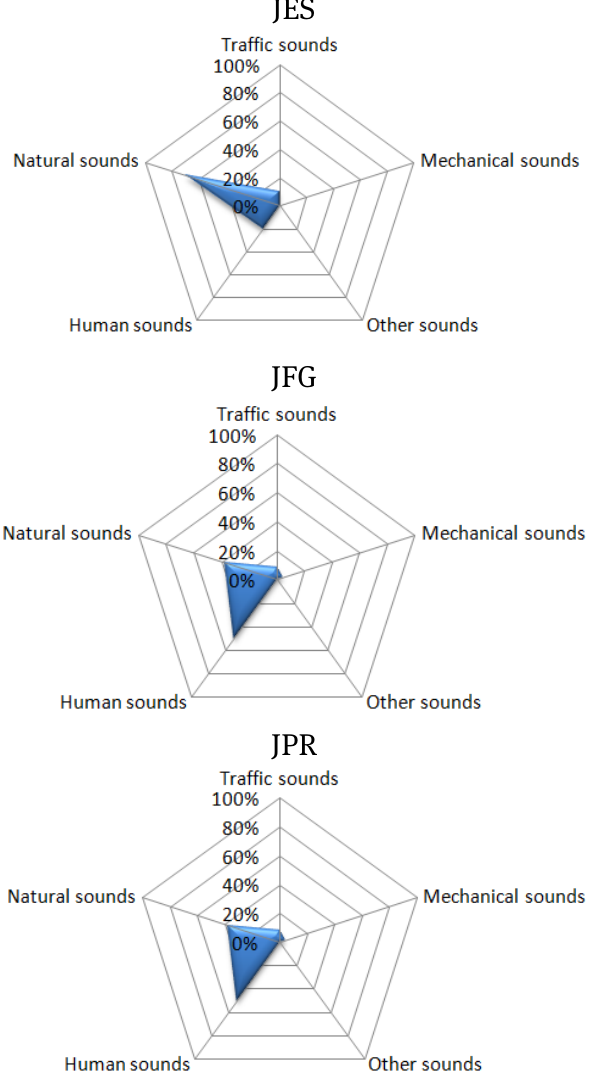
Figure 3: Sound components identified in Lisbon parks.